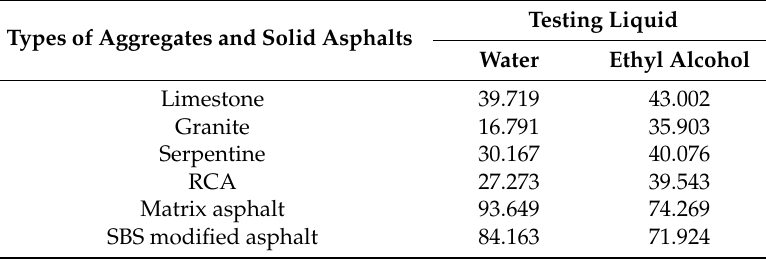
Table 6. CA results of Aggregates and solid